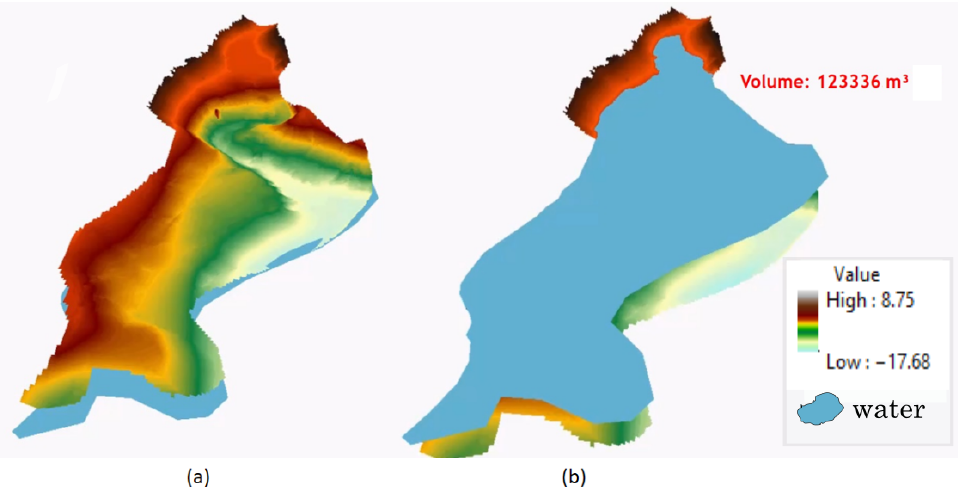
Figure 13. Three dimensional (3D) model for rendering visualization analysis; ( a ) shows the geomor- phology of the entire merged area, while ( b ) shows the results of water flow modeling and water volume